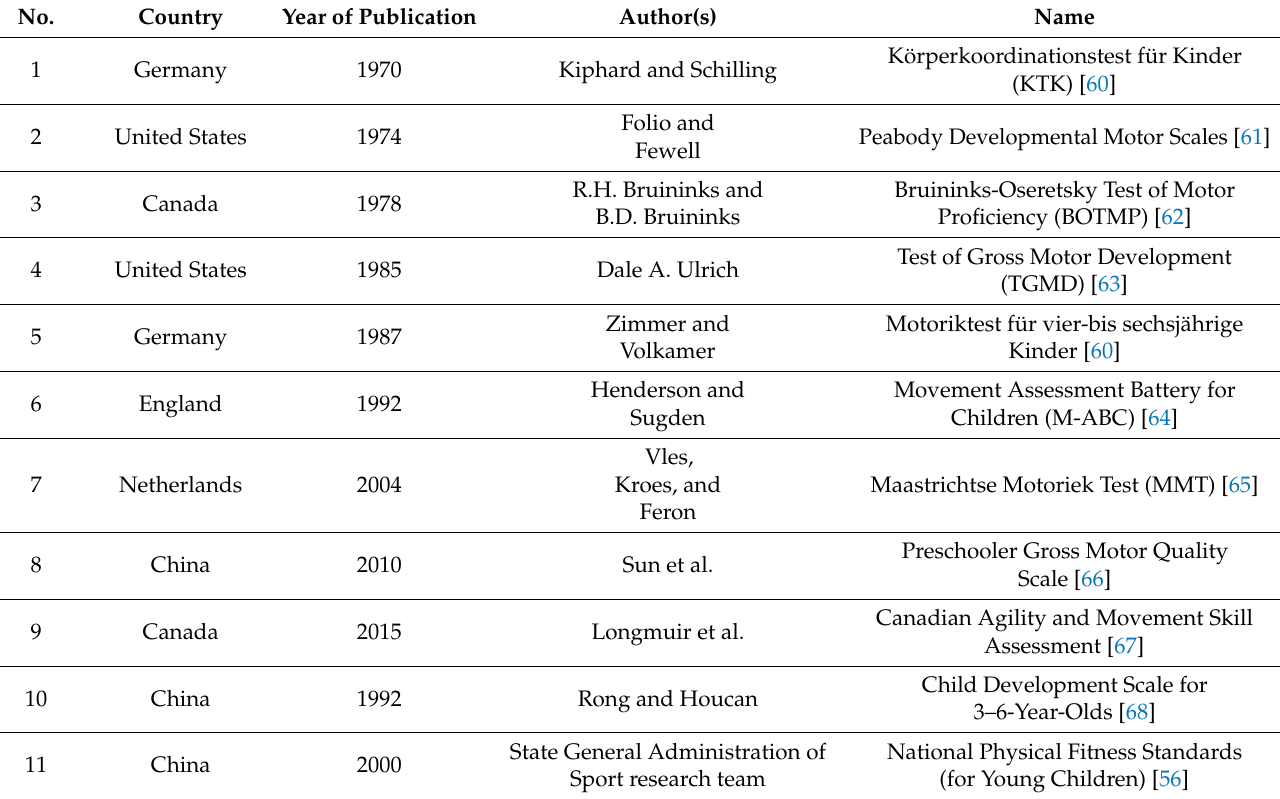
Table 2. Commonly used children’s movement skill measurement scales